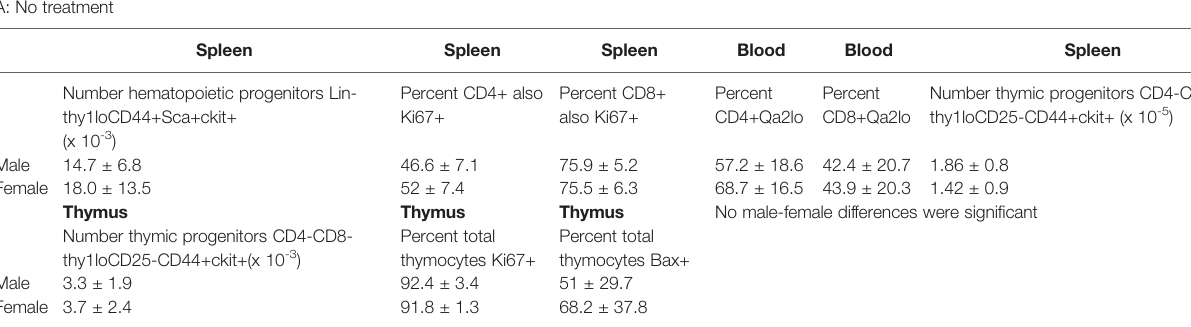
TABLE 1 | Cell values 7 days postpartum comparing both male to both female